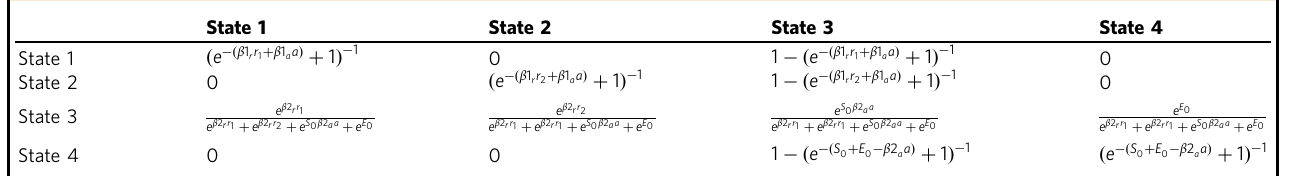
Table 1 The transition probabilities between the various states of the model.